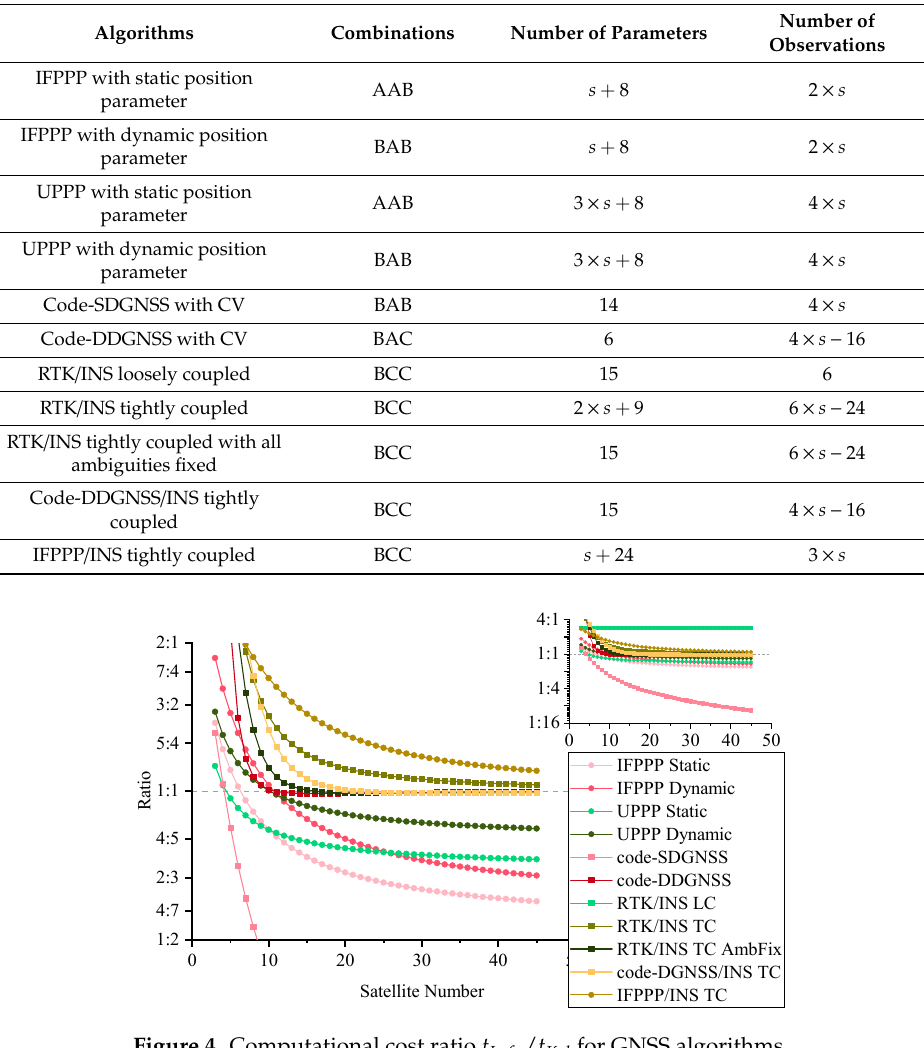
Table 9. Number of parameters, number of observations, and factor combination of GNSS algorithms. CV: constant velocity.